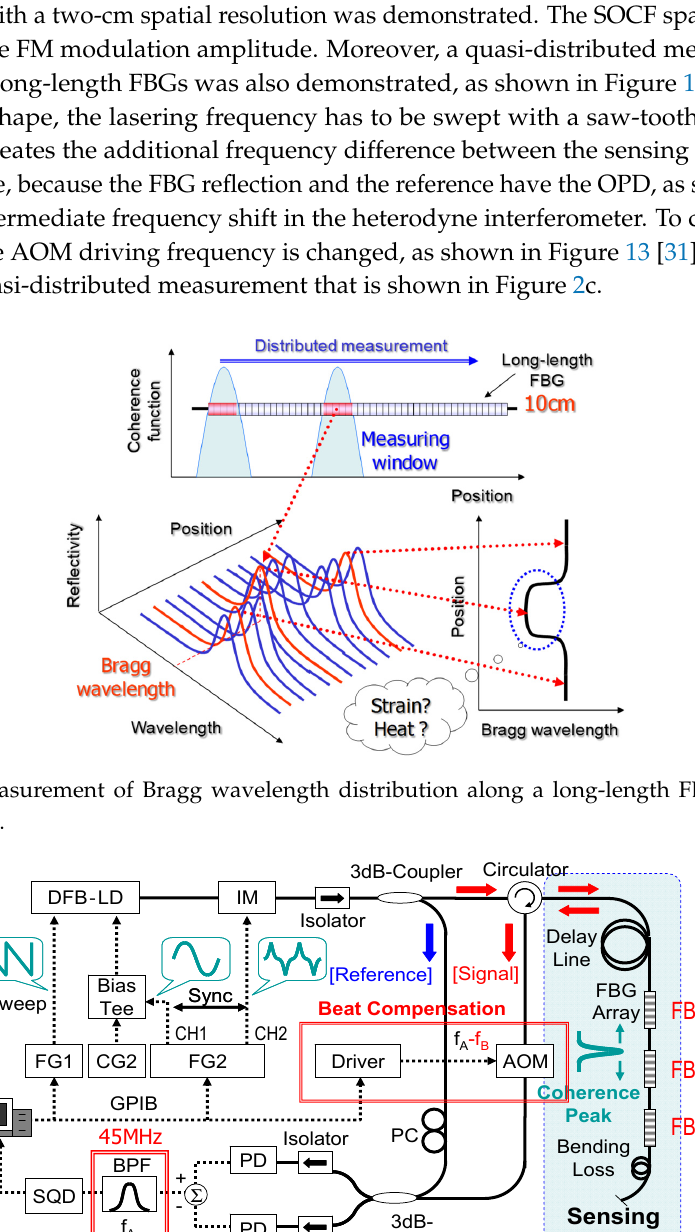
Figure 11. Time-resolved simultaneous measurement of reflection spectra at multiple FBGs with the